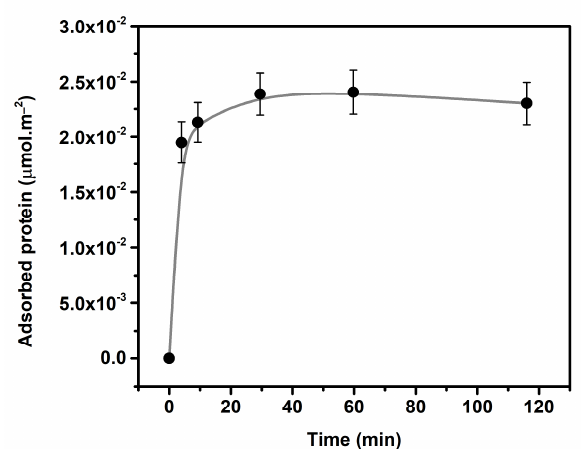
Figure 3. Amount of adsorbed protein (expressed in micromoles of protein per surface area unit of ◦ support) onto Ns SiO 2 as a function of time at 30 °C. support) onto Ns SiO 2 as a function of time at 30